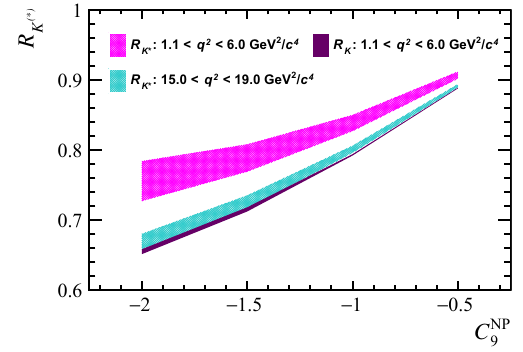
Fig. 6 Predictions of R K ∗ at large recoil (hatched magenta) and low recoil (hatched cyan), and R K at large recoil (solid burgundy) for dif- ferent values of C NP . The R K values at low recoil are identical to those 9 μ at large recoil and thus not shown. The interval for R K ∗ is determined using the model described in Sect. 2, considering the full variation of the unknown phases θ 0 . In contrast the 68% confidence interval of the j R K prediction is obtained using the measured non-local contributions in B − → K − μ + μ − decays